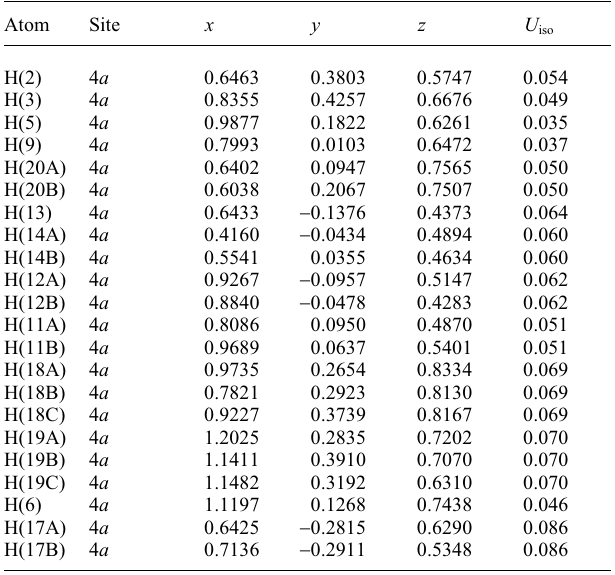
Table 2. Atomic coordinates and displacement parameters (in Å 2 ) .